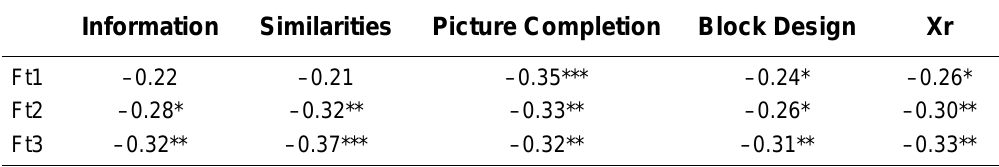
Interrelationship Between Wechsler Intelligence Subtests and the Distribution of Errors (Commissive and Omissive) over Three Periods, Ft1, Ft2, and Ft3 (Beginning, Middle,